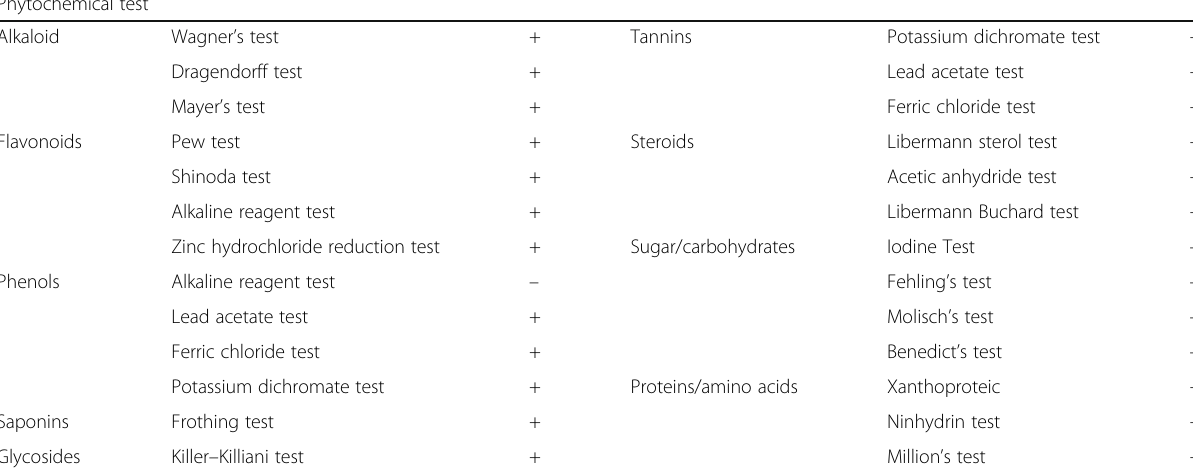
Table 1 Phytochemical analysis of hydro-methanolic extract of Sterculia urens Roxb. root Phytochemical test